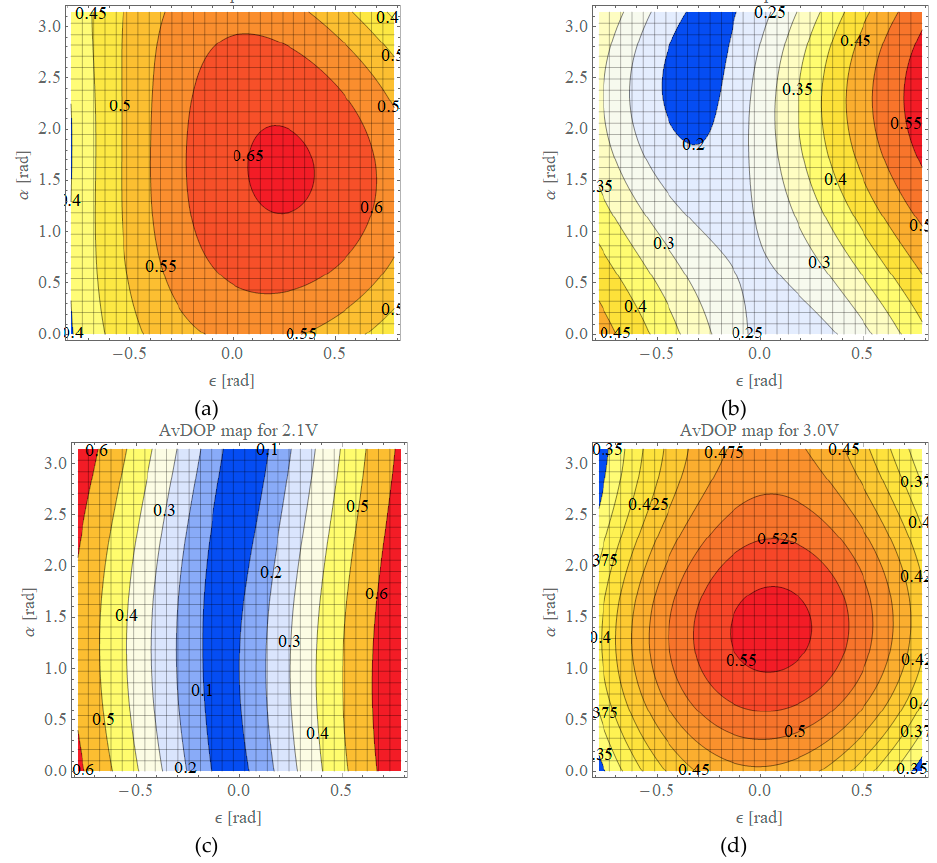
Figure 5. Calculated AvDOP maps for PVAN cells with thicknesses: 10 μ m ( a ) & ( b ) and 15 μ m ( c ) & ( d ) for following voltages and input SOPs ( a ) 1.95 V & circular R, ( b ) 2.1 V & linear H, ( c ) 2.1 V & linear H and ( d ) 3 V & circular R.